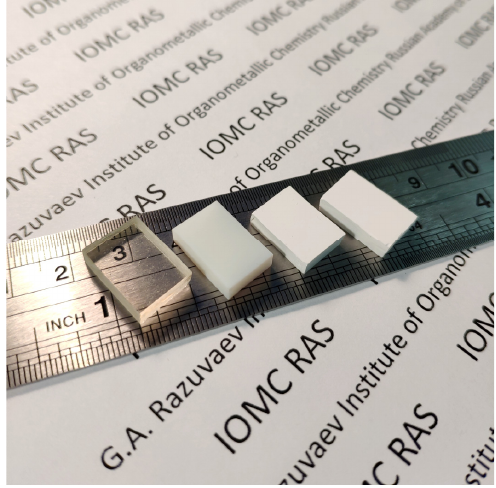
Figure 2. Photograph of 4 mm thickness porous polymer obtained from various compositions of